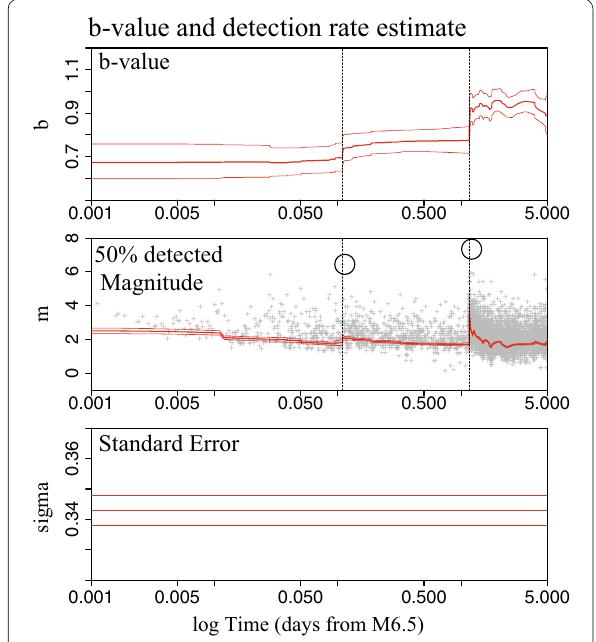
Fig. 10 Earthquake detection-rate parameters and b -value estimates. The panels show, from top to bottom, the b -value time change and the detection-rate parameters with double error (95%) envelopes versus time on a logarithmic scale. The vertical dashed lines show the occurrence times of the M6.4 and M7.3 earthquakes, which are marked by large